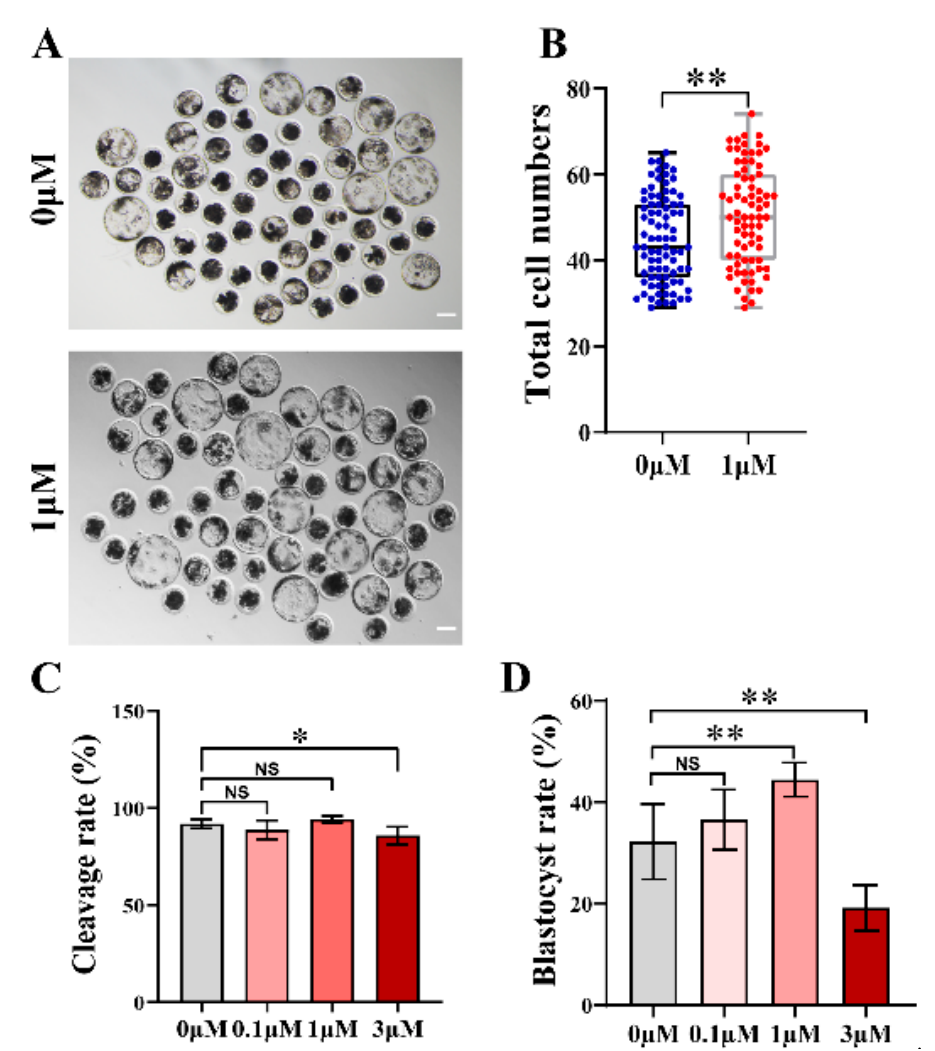
Figure 1. Effects of chrysoeriol (CHE) on the development of porcine parthenogenetic oocytes. ( A ) Embryo growth at 7 days in the 0 µ M (control) group and 1 µ M (CHE-treated) group. Scale bar = 100 µ M. ( B ) Total number of cells in blastocysts on day 7 in the control group (n = 83) and the CHE-treated group (n = 75) R = 7. Data represent medians and maxima and minima. Significant difference is showed with ** ( p < 0.01). ( C ) Cleavage rates of oocytes at different concentrations of CHE during development, divided into the 0 (n = 283), 0.1 (n = 282), 1 (n = 279), and 3 µ M (n = 277) groups according to the concentration of CHE. R = 7. Differences are shown as NS (not significant) and significant, i.e., * ( p < 0.05). ( D ) The blastocyst formation rate at 7 days at the different concentrations, 0 (n = 250), 0.1 (n = 249), 1 (n = 246), and 3 µ M (n = 244). R = 6. Differences are NS (not significant) or significant, i.e., ** ( p <